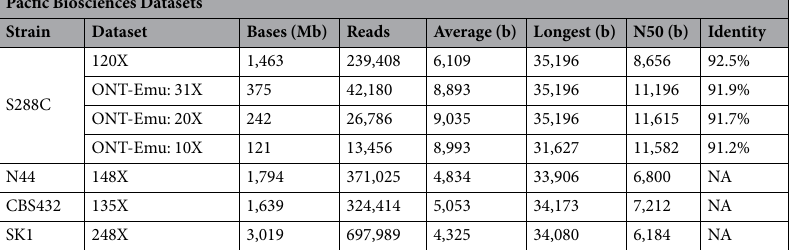
Table 2. Statistic information for the PacBio datasets for the S288C, N44, CBS432 and SK1 strains. For the S288C strain also the ONT-emulating subsets are shown: ‘ONT-Emu’ 31X, 20X and 10X subsets, selected to match the 31X, 20X and 10X ONT S288C datasets for depth and read length